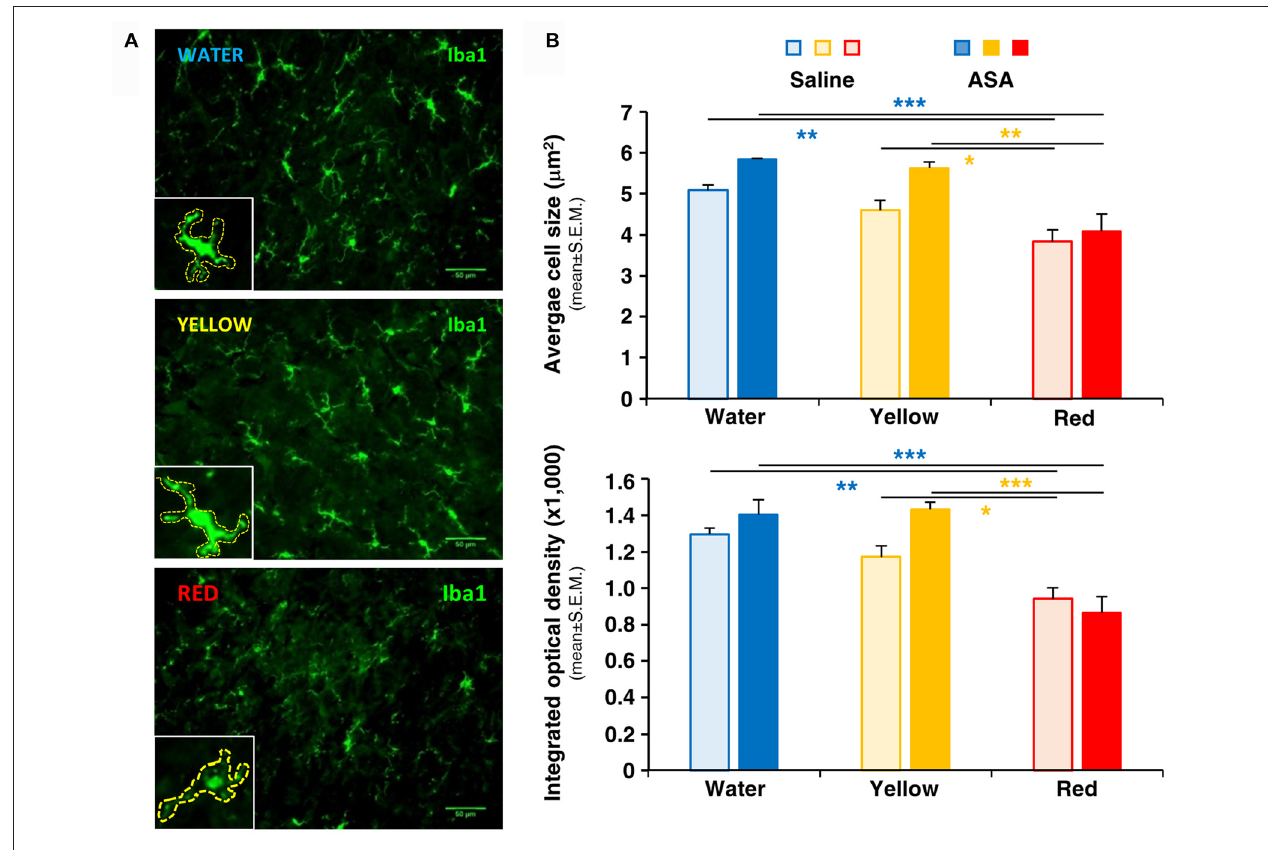
FIGURE 3 | Red extract inhibits the activation of Iba1+ microglia in the brainstem of CFA-injected rats. No effects of ASA. (A) Representative pictures of Iba1+ microglia in the medulla oblongata of the brainstem of CFA-injected rats drinking water, yellow or purple corn extracts (from top to bottom). Scale bars: 50 µ m. Insets: magnification of representative microglia cells, showing thinner and feebly stained processes in rats drinking Red extracts with respect to rats drinking water or Yellow extract. Cells have been highlighted by dashed lines to perform quantitative analysis (see “Materials and Methods” section for details). (B) Histograms showing the average cell size (top) and the mean integrated optical density of Iba1 staining (bottom) in CFA-injected animals drinking water, Yellow or Red extracts and treated with saline (light colored-bars) or 50 mg/kg ASA (dark colored-bars). Animals have been sacrificed at 72 h post CFA injection (see protocol in Figure 1 and text for details). N = 4 (Water), 3 (Yellow) and 5 (Red) rats treated with saline, and three (Water, Yellow and Red) rats treated with ASA. ∗ p < 0.05, ∗∗ p < 0.01 and ∗∗∗ p < 0.001 with respect to corresponding purple corn supplement, two-way ANOVA followed by Bonferroni